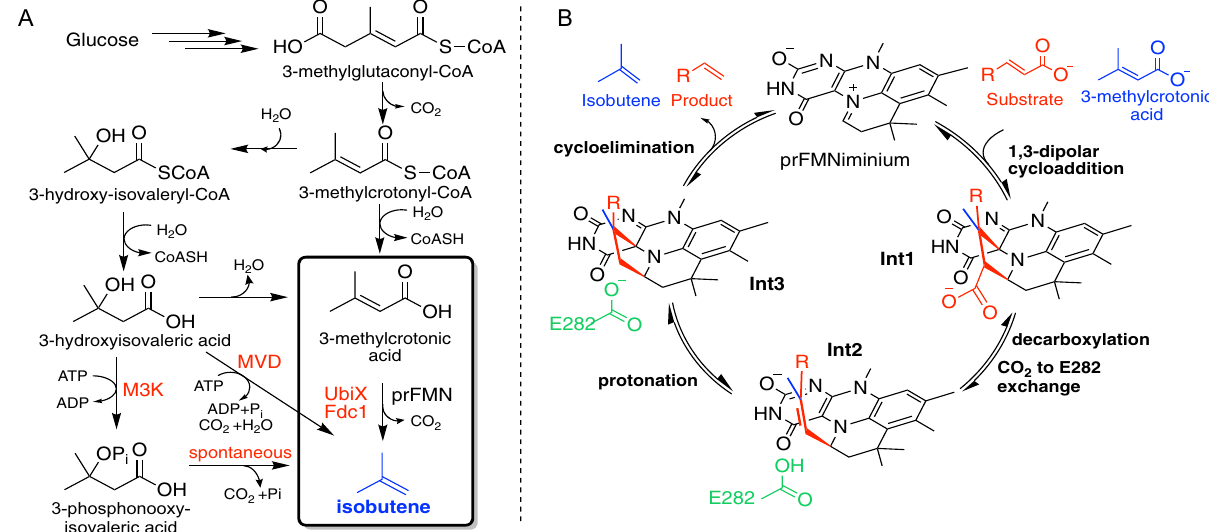
Fig. 1 Isobutene production via the modi fi ed mevalonate pathway utilizing Fdc for the last step. A Routes to isobutene via modi fi ed mevalonate pathways. Previously published mevalonate diphosphate decarboxylase (MVD) 7 and mevalonate-3-kinase (M3K) 9 produce isobutene via 3-hydroxyisovaleric acid. Fdc1, co-expressed with UbiX, catalyses the decarboxylation of 3-methylcrotonic acid to give isobutene. B Fdc decarboxylation reaction mechanism with 3-methylcrotonic acid in blue and common Fdc substrates with a conjugated R-group in red. First, the 1,3-dipolar cycloaddition of the substrate to prFMN iminium leads to the fi rst pyrrolidine cycloadduct, Int1 . Decarboxylation and ring-opening forms the noncyclic alkene adduct Int2 . Protonation by a conserved glutamic acid residue yields the second pyrrolidine cycloadduct Int3 followed by cycloelimination to give the